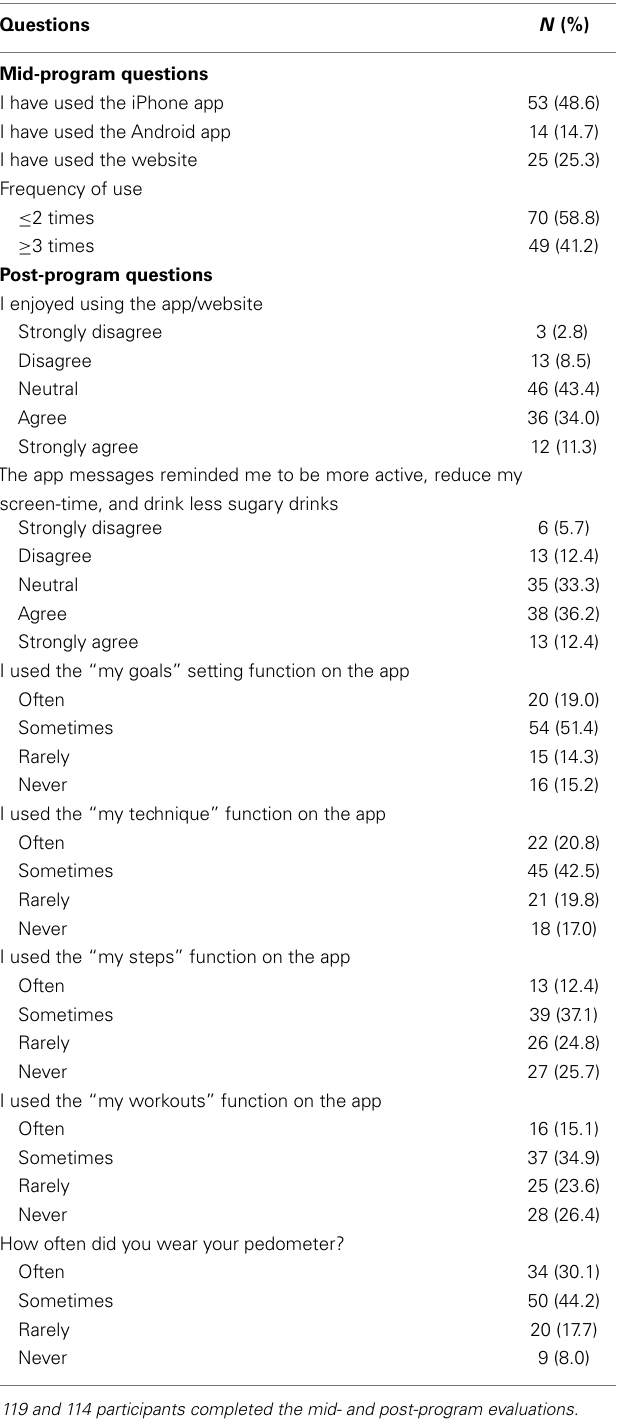
Table 2 | Mid- and post-program process evaluation questions and responses